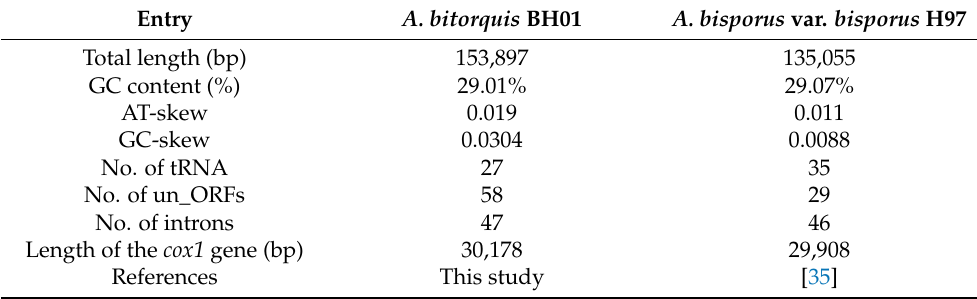
Table 2. Mitogenomic comparison between A. bitorquis and A. bisporus